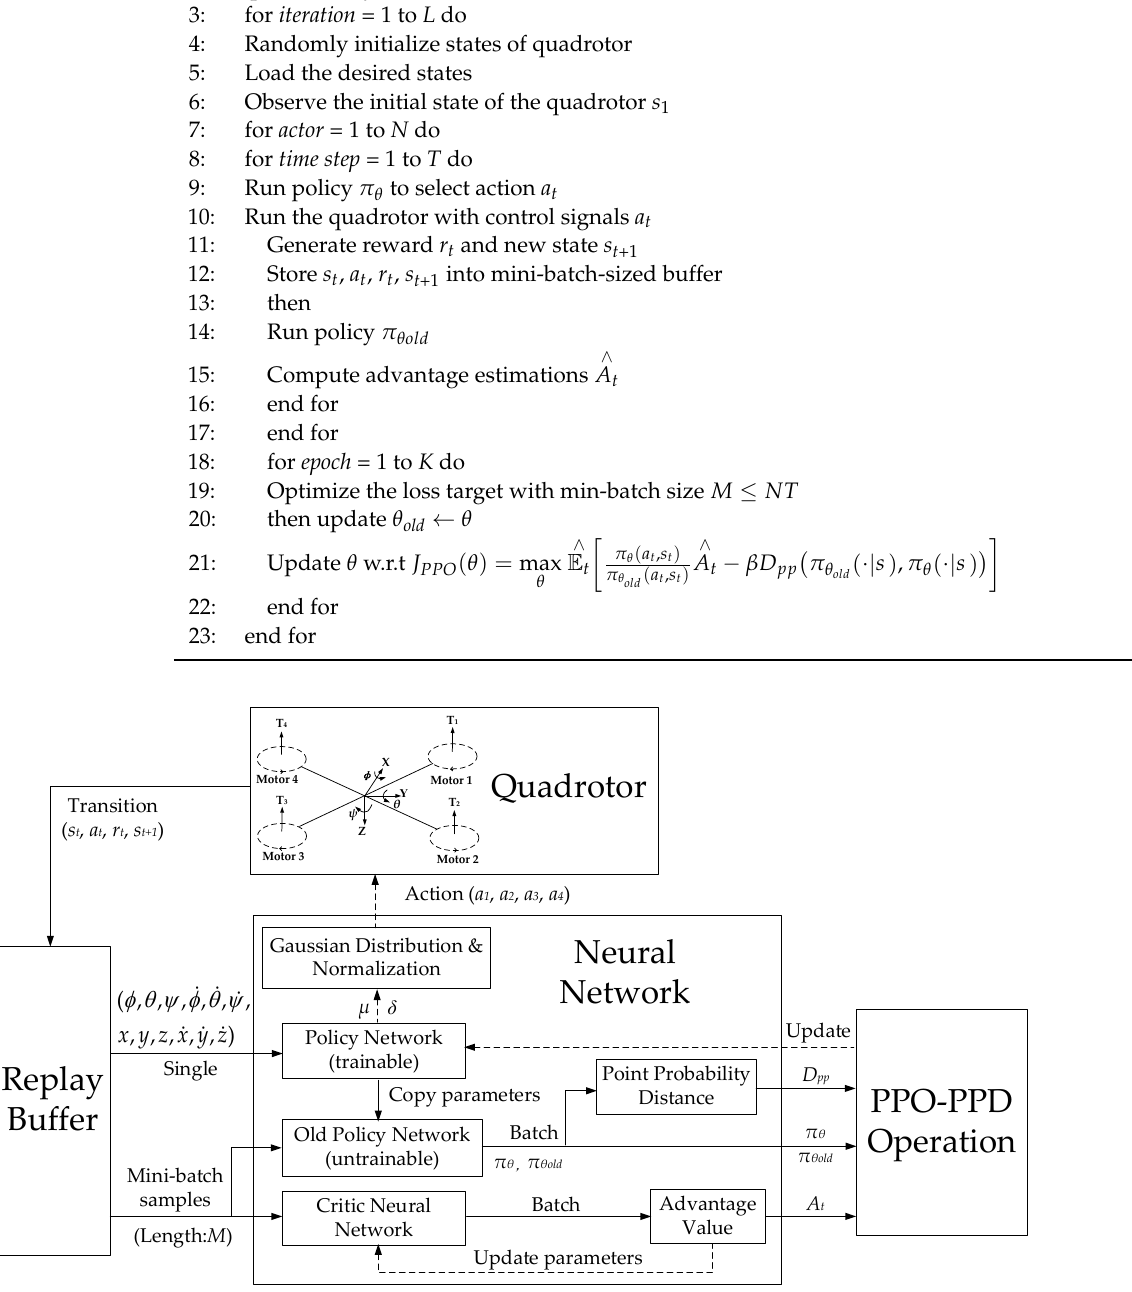
Figure 4. Schematic diagram of the policy update.